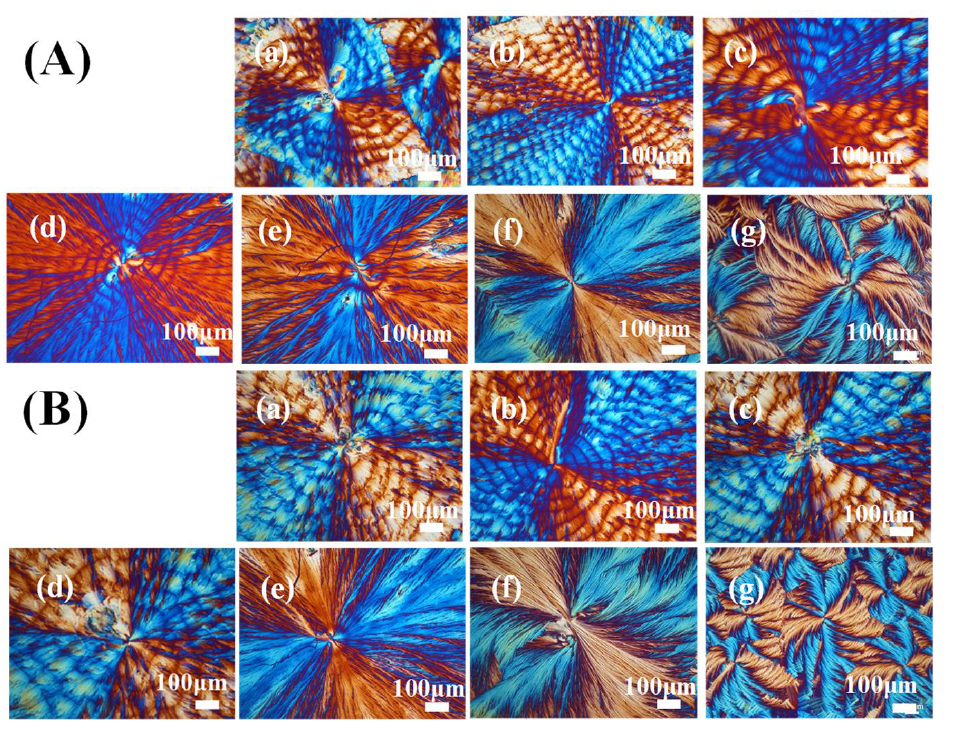
Figure 1. POM graphs of ( A ) (R)-MA/PVPh and ( B ) (S)-MA/PVPh blends crystallized at T c = 60 °C for different compositions: ( a ) 90/10, ( b ) 85/15, ( c ) 80/20, ( d ) 75/25, ( e ) 70/30, ( f ) 60/40, and ( g ) 50/50.